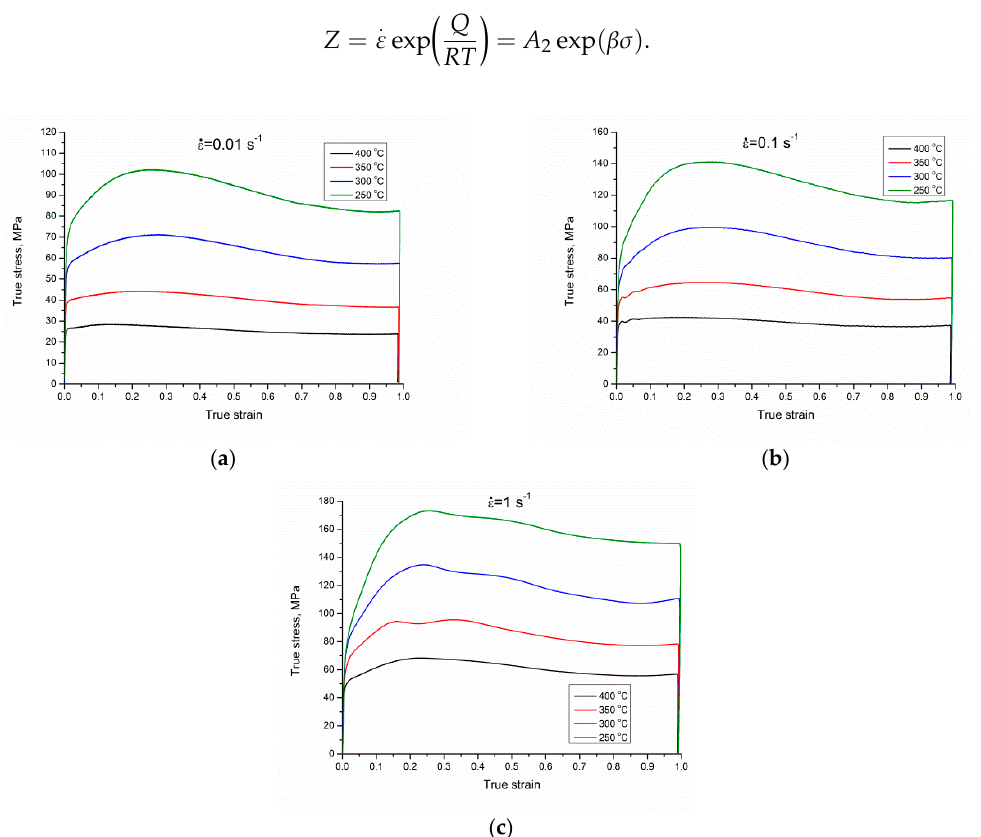
Figure 3. The true stress–strain curves of the Mg–4.5 Li–1.5 Al + 0.2 TiB alloy during hot compression tests at varying strain rates: ( a ) 0.01 s − 1 ; ( b ) 0.1 s − 1 ; ( c ) 1 s − 1 .